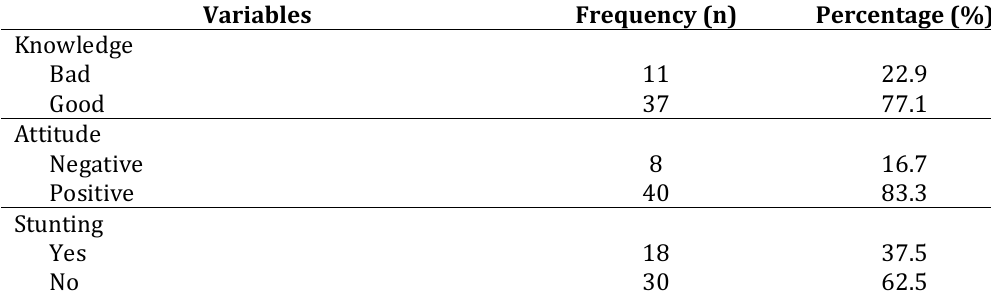
The frequency distribution of knowledge, attitude, and stunting evidence